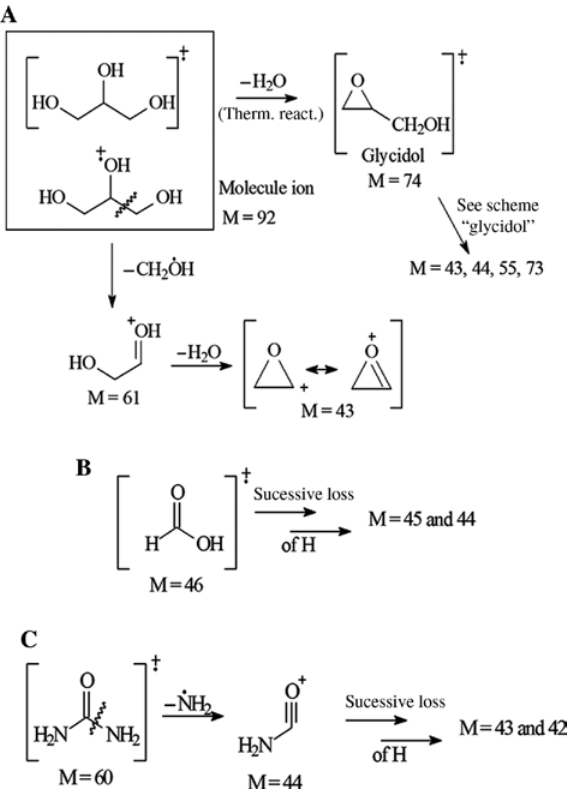
Figure 6: Plausible fragmentation paths for radical cations of (A) glycerin, (B) formic acid and (C) urea. Also, some trace amounts of two undesired com- pounds, i.e. glycidol and formamide have been detected in both trials. Glycidol showed m/z of 44, 43, 55 and 73 (as shown in Figure 7), while the effective m/z data for formamide were 45, 44, 43 and 42 which might be asso- ciated with successive hydrogen loss. In fact, glycidol is formally the dehydration product of glycerin and it can